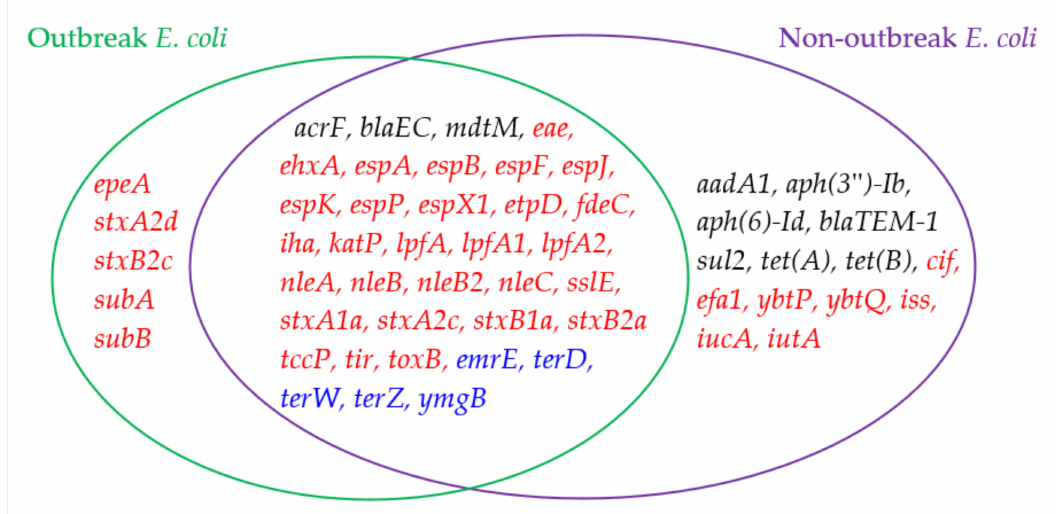
Figure 2. A comparison of outlier genes detected in outbreak E. coli and non-outbreak E. coli